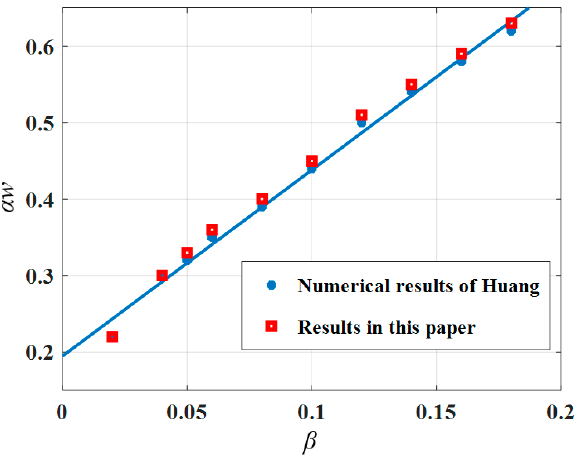
Figure 4. The twist angle per unit length along the stem α w with intrinsic strain β .